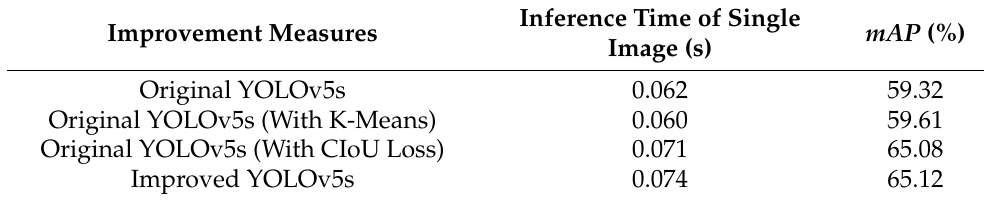
Table 3. Comparison of effects of K-Means clustering algorithm and